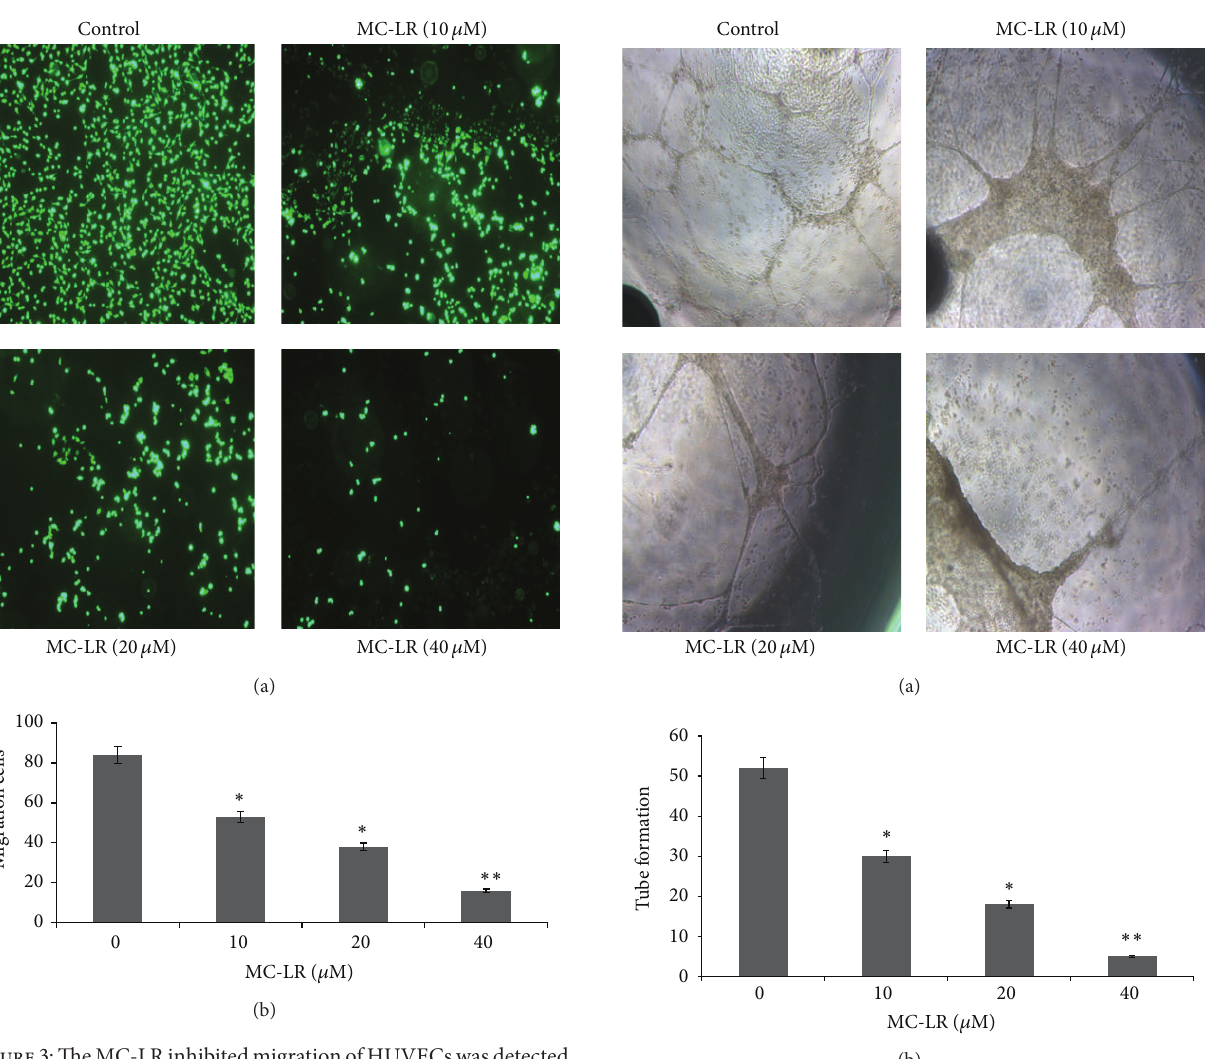
Figure 3: The MC-LRinhibited migration of HUVECs was detected by transwell assay. Representative microphotographs are shown. ∗ 𝑝 < 0.05 and ∗∗ 𝑝 < 0.01 versus control ( 𝑛 = 3 independent experiments).